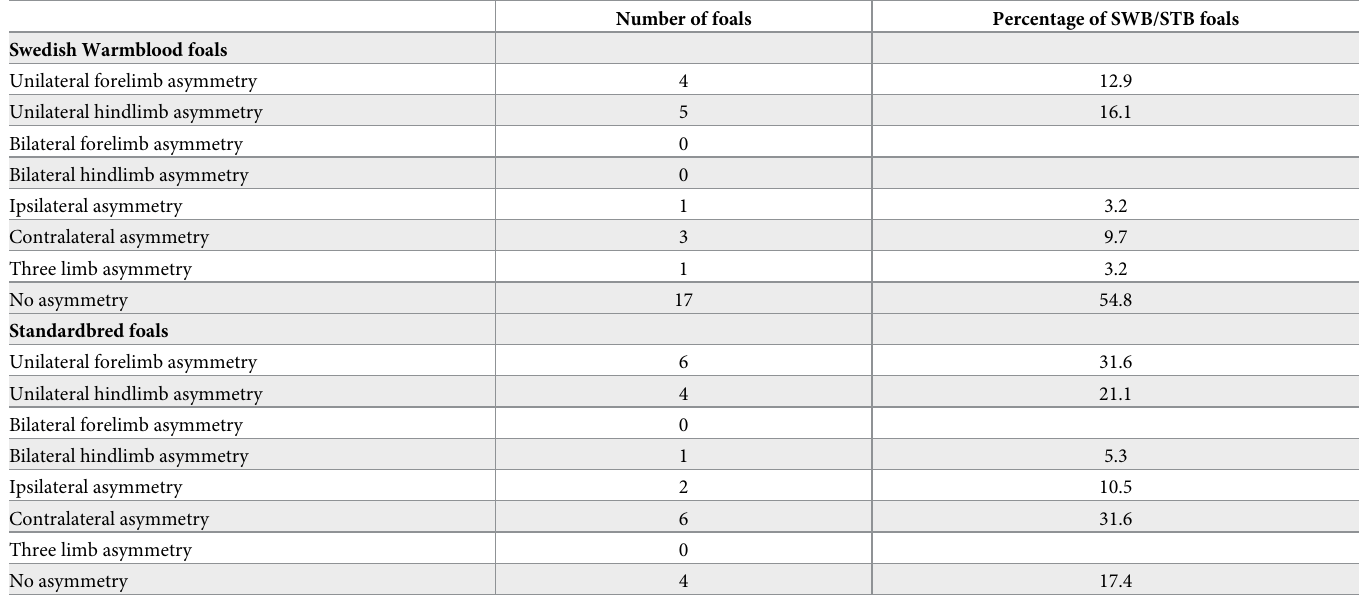
Table 2. Frequency distribution of Swedish Warmblood (SWB) and Standardbred (STB) foals with no, one or multiple movement asymmetry parameters above